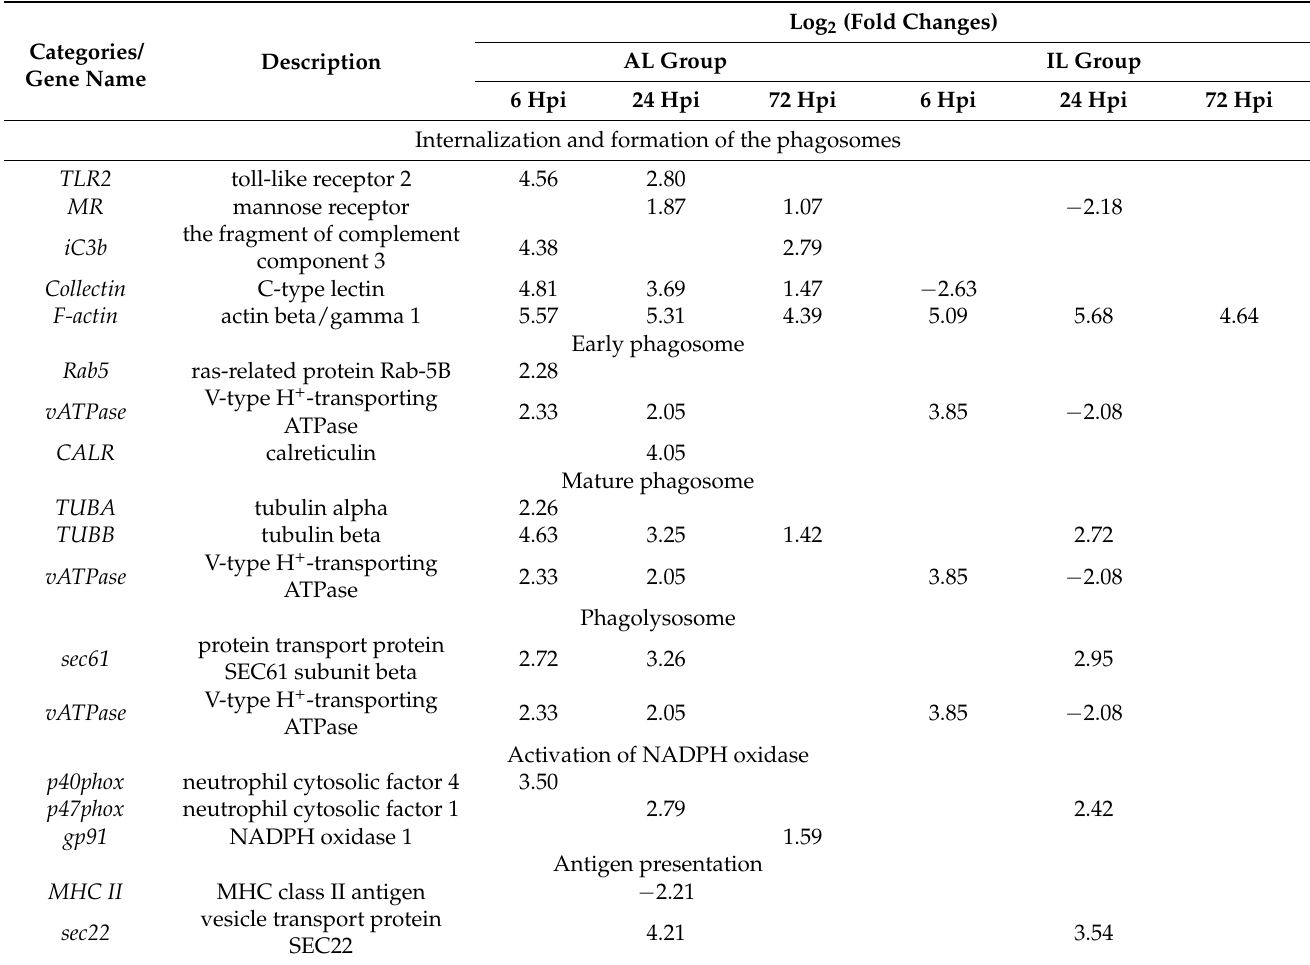
Table 2. Fold changes of differentially expressed phagocytosis-related genes in the AL group and the IL group compared to the